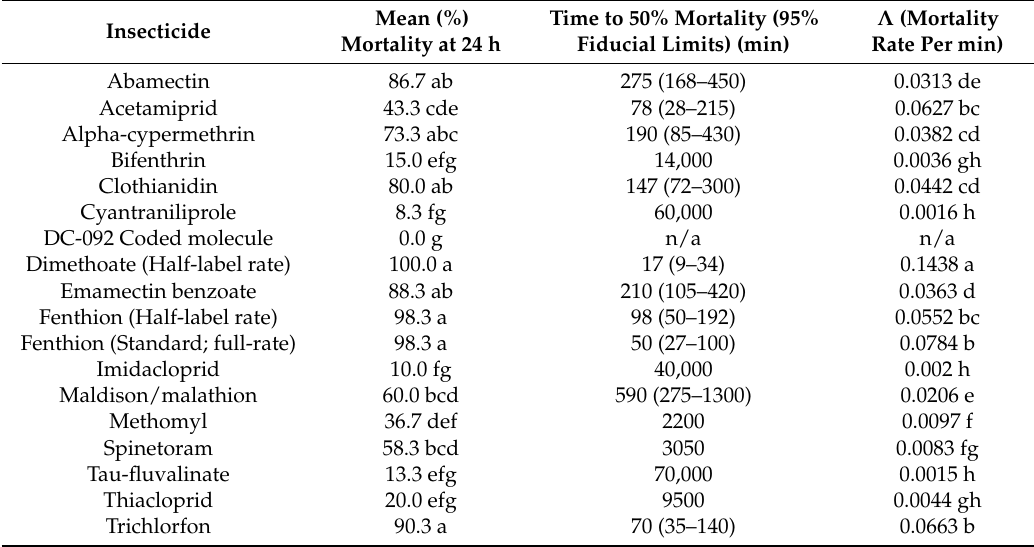
Table 2. The mean percentage mortality at 24 h, time to reach 50% mortality, and the instantaneous mortality rate ( λ ) of adult Bactrocera tryoni exposed to fruit dipped in insecticide (bioassay 1). Weibull’s shape parameter α = 0.55.